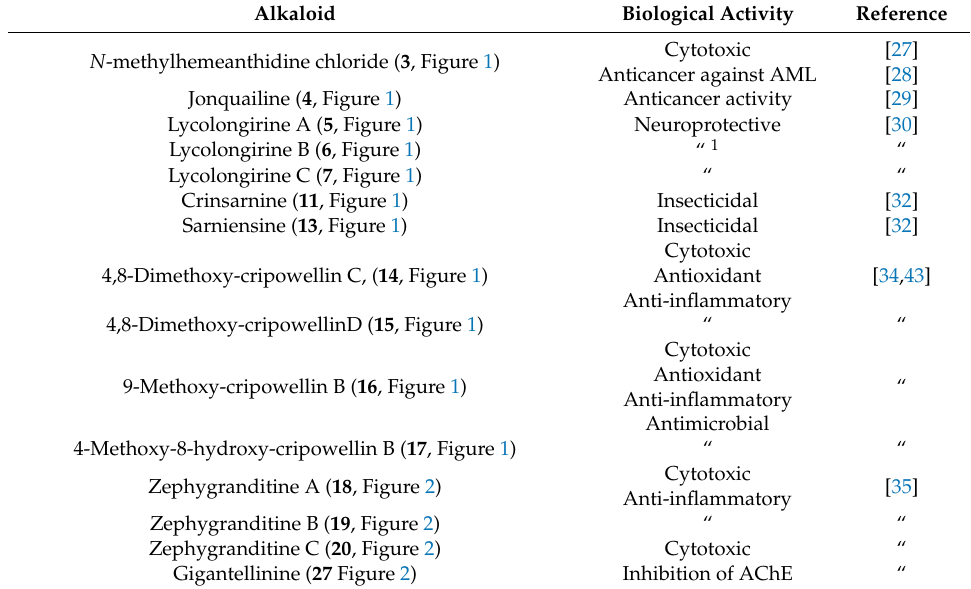
Table 2. Biological activities of Amaryllidaceae alkaloids and natural analogues isolated in the last